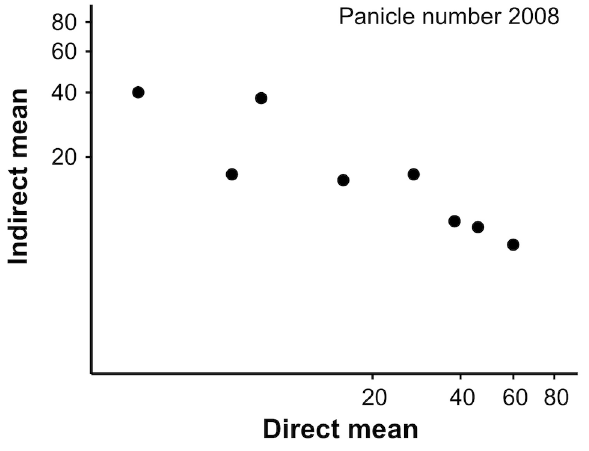
Figure 3. The relationship between direct and indirect genetic effects for panicle number in 2008. The scatter plot compares the direct mean of each genotype (averaged across pair mates) with the indirect mean induced by that genotype on its neighbour (averaged across pair mates). Pearson r = 2 0.89, P , 0.01.